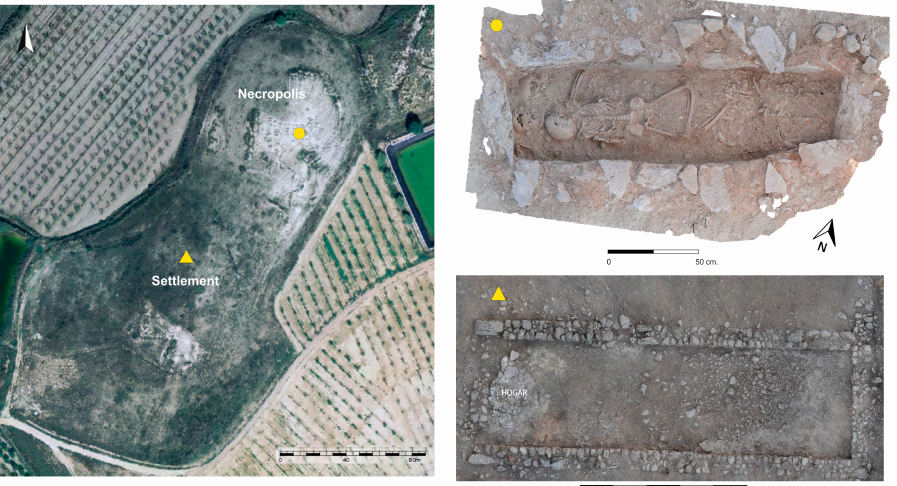
Figure 6. Details of the evidence documented in the recent excavation of LE. The top panel shows a reused burial with three Visigothic individuals (the yellow circle marks the location of the grave that appears in the detail image); the bottom panel shows a room that was part of a larger building, which could have been a domestic space with several rooms (the yellow triangle marks the location of the structure that appears in the detail image).